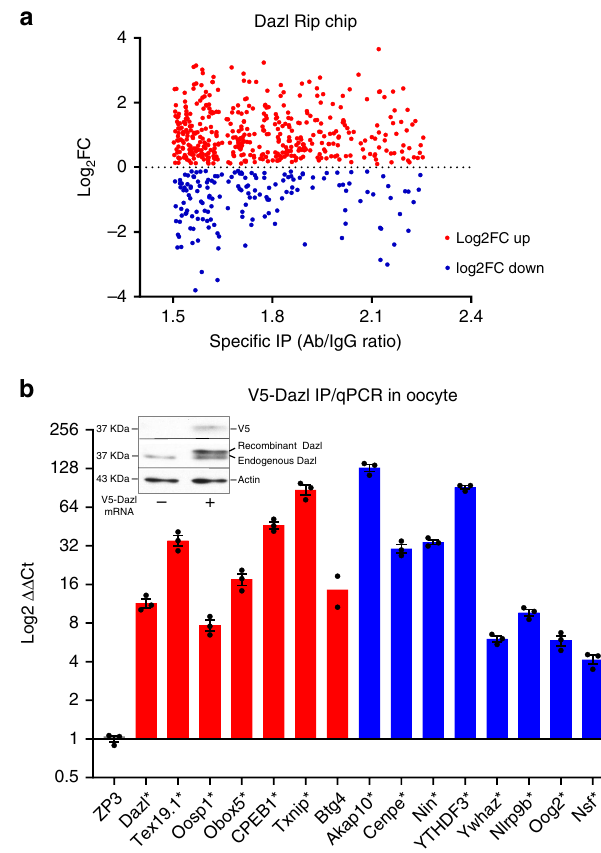
Fig. 4 DAZL physically interacts with transcripts whose translation is upregulated or downregulated during oocyte maturation. a Comparison DAZL Rip-Chip and polysome array in oocytes. Changes in ribosome loading from 0 h (GV) to 16 h (MII stage) is reported in the y axes, while the interaction with DAZL assessed by RIP-Chip is reported in the X axes. Subset of transcripts whose translation increased from GV to MII stage are also enriched in DAZL immunoprecipitates of oocyte extracts (red); transcripts whose translation decreases during oocyte maturation and speci fi cally immunoprecipitated by DAZL antibody (blue). The GV/MII ribosome loading data are those published in ref. 21 . For DAZL RIP-Chip, oocytes were obtained from mice primed with PMSG and hCG. Oocyte lysates was immunoprecipited with DAZL-speci fi c antibody or IgG and the mRNA recovered in the IP pellet measured by microarray hybridization. Each dot is the average of three independent biological replicates ( b ) Interaction of DAZL with selected targets upregulated or downregulated in oocytes after DAZL depletion. Oocytes were injected with a V5-tagged Dazl construct. After overnight incubation in milrinone, oocytes were extracted and an aliquot was used for WB (inset) or used for RIP/qPCR. Data are presented as bars with means ±SEM of n = 3 biologically independent experiments except for Btg4 where N =